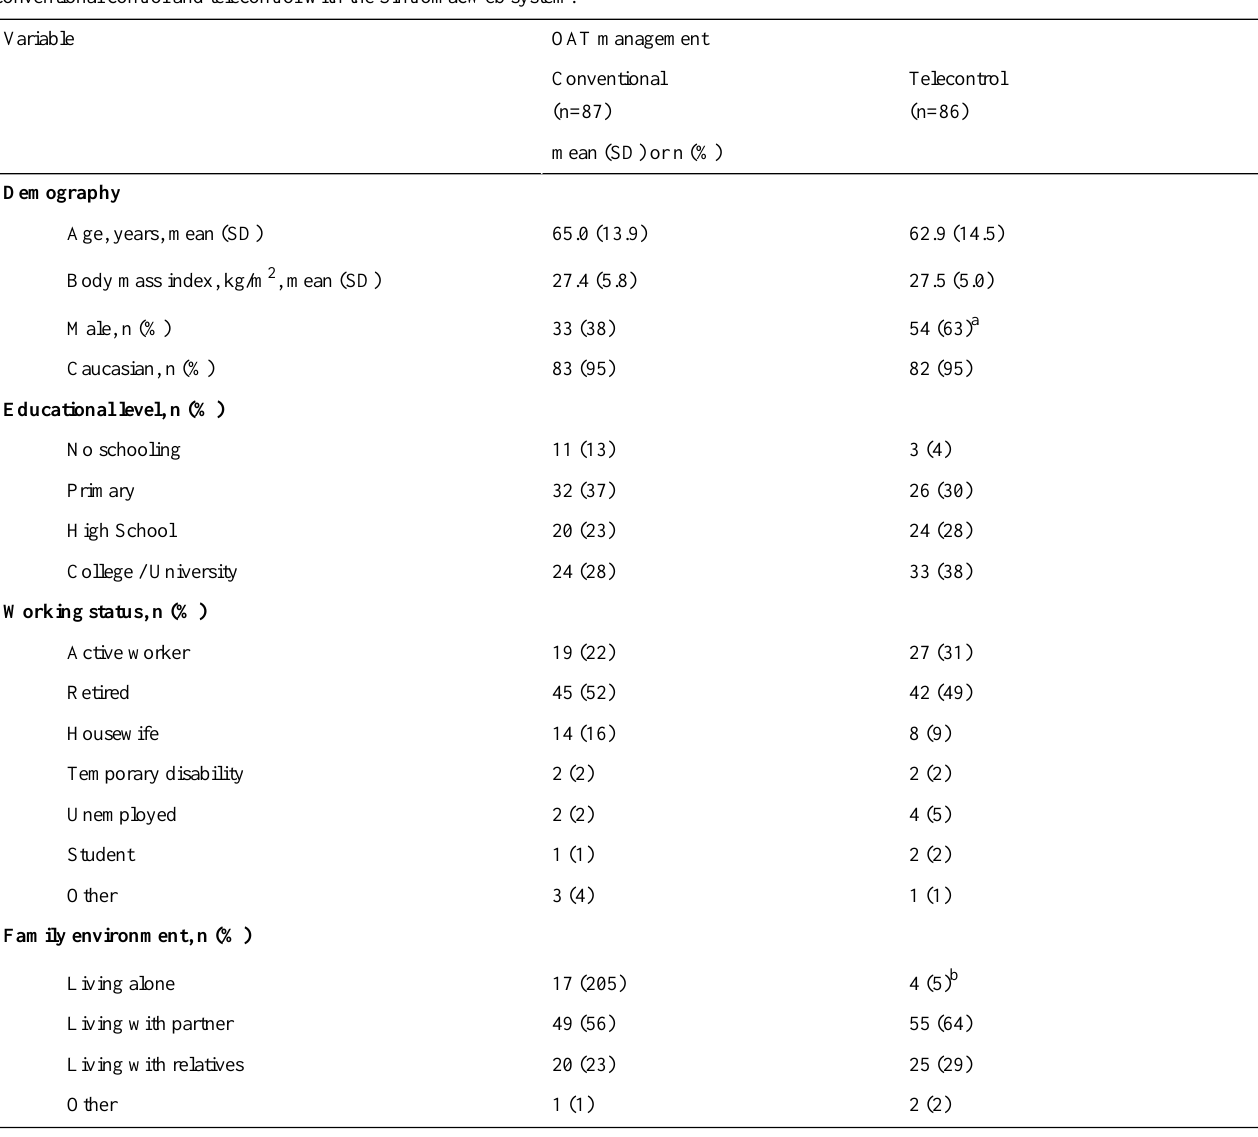
Table 1. Demographic, socio-cultural, and environmental profile of patients in the two oral anticoagulant therapy (OAT) management study groups: conventional control and telecontrol with the SintromacWeb